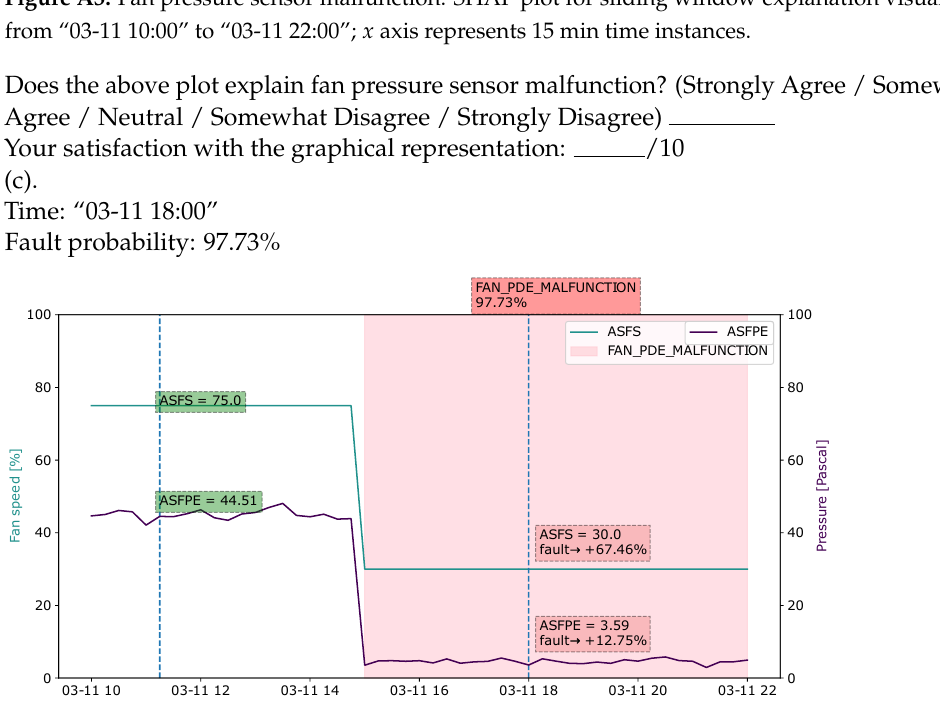
Figure A4. Fan pressure sensor malfunction. Modified SHAP plot for sliding window explanation; x axis represents 15 min time instances.